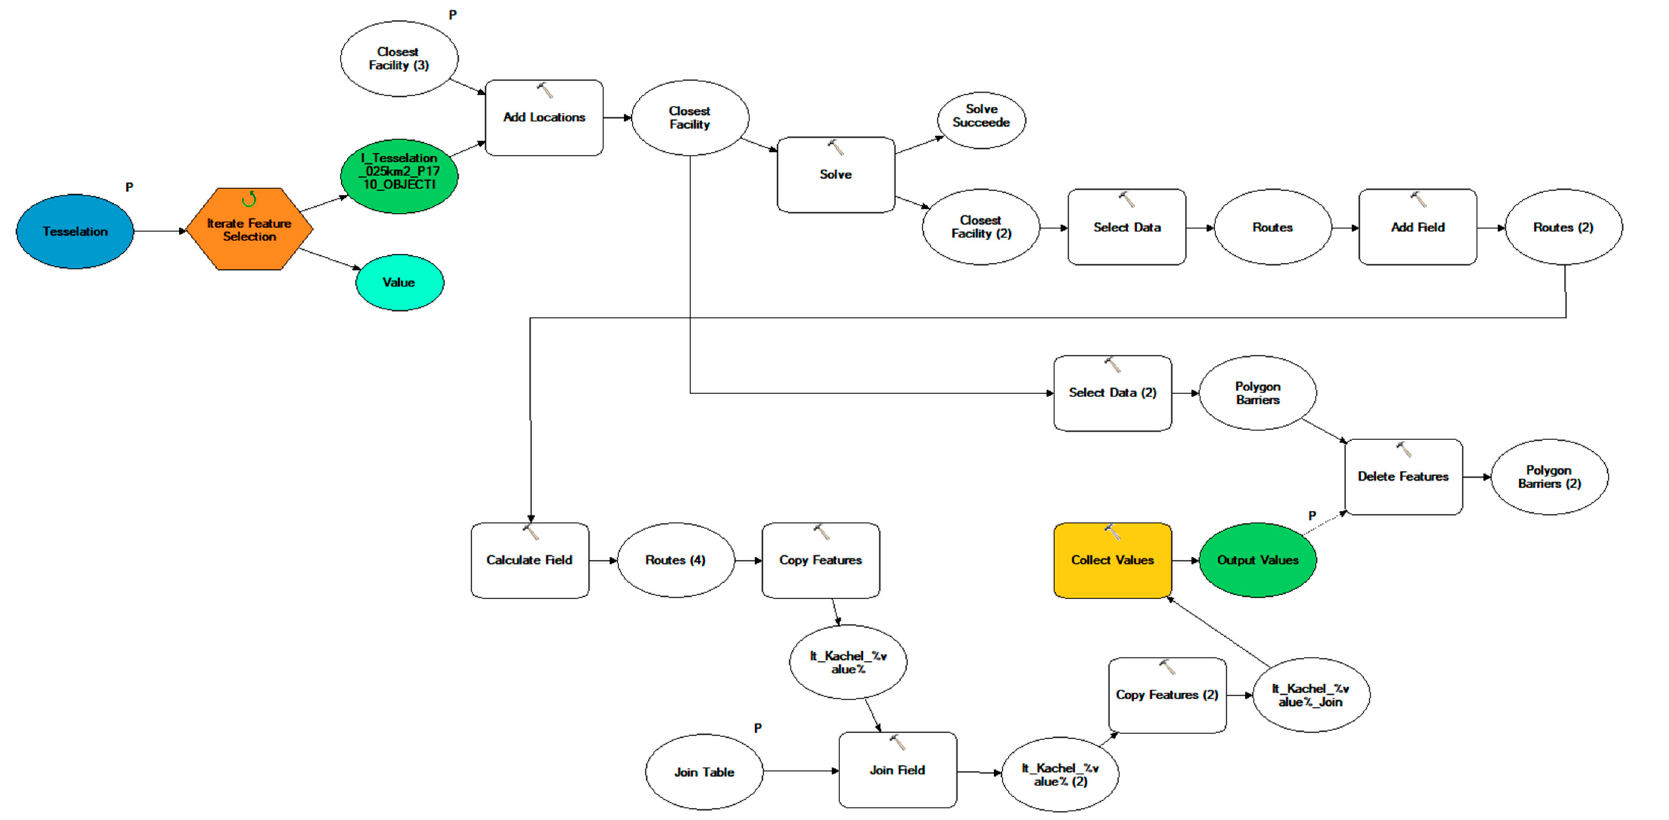
Figure A3. Iteration Sub-Level (CF_Iteration) in ArcMap ModelBuilder.